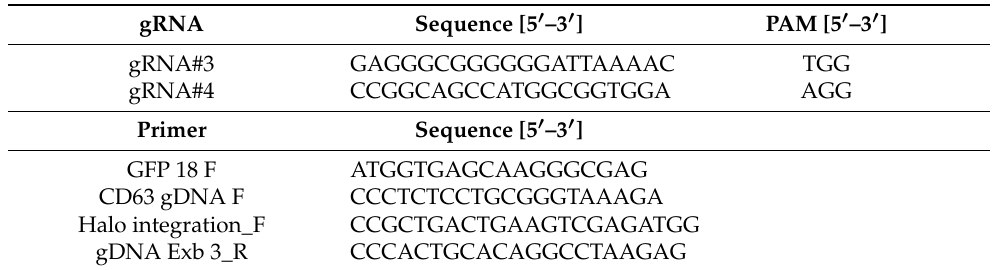
Table 1. The gRNA and primer sequences for CRISPR/Cas9 approach and integration PCR. gRNA Sequence [5 (cid:48) –3 (cid:48) ] PAM [5 (cid:48) –3 (cid:48)